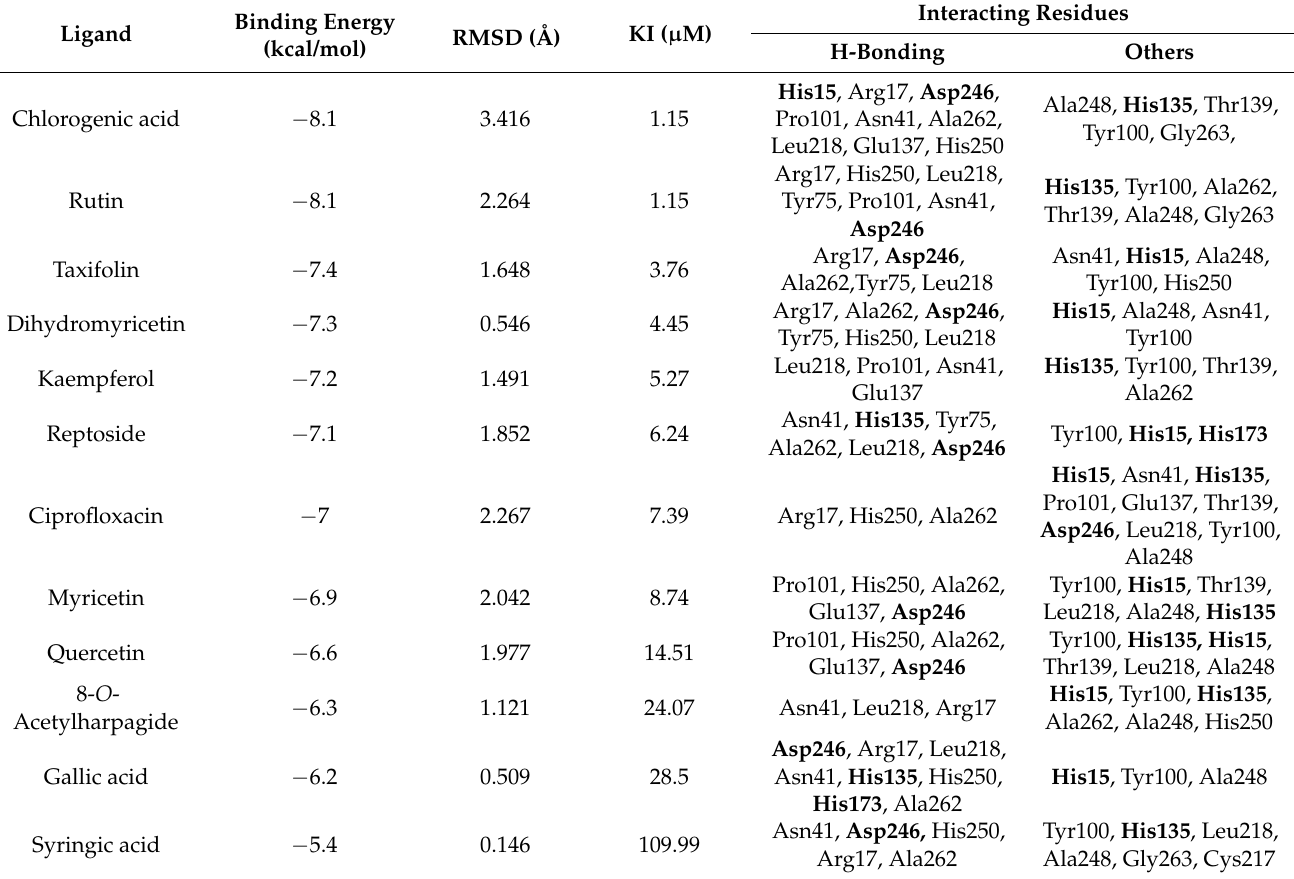
Table 6. Result summary of molecular docking analysis of ligands with VcDHO protein (PDB ID: